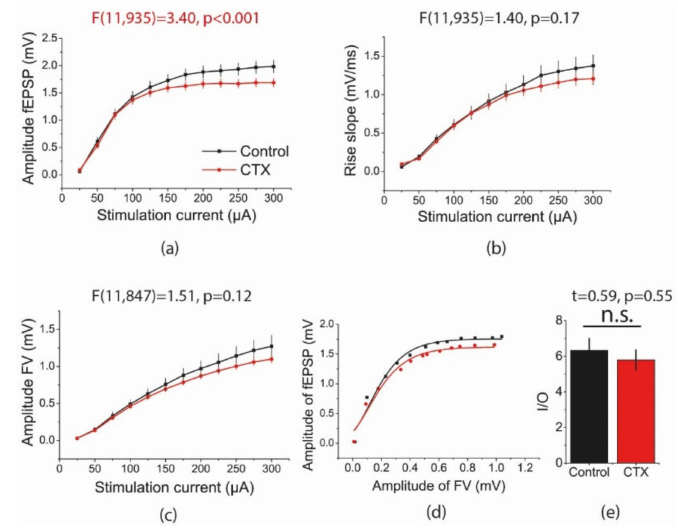
Figure 3. Stimulation response relationships for field excitatory postsynaptic potential (fEPSP) amplitudes ( a ) and slopes ( b ) and presynaptic fiber volley (FV) amplitudes ( c ) recorded in the hippocampal CA1 area. Each point represents the mean ± SEM. ( d ) Representative examples of input / output (I / O) relationships between the fEPSP and FV amplitudes in hippocampal slices in control and ceftriaxone (CTX)-treated rats. ( e ) The maximal I / O slope was unchanged after CTX treatment.